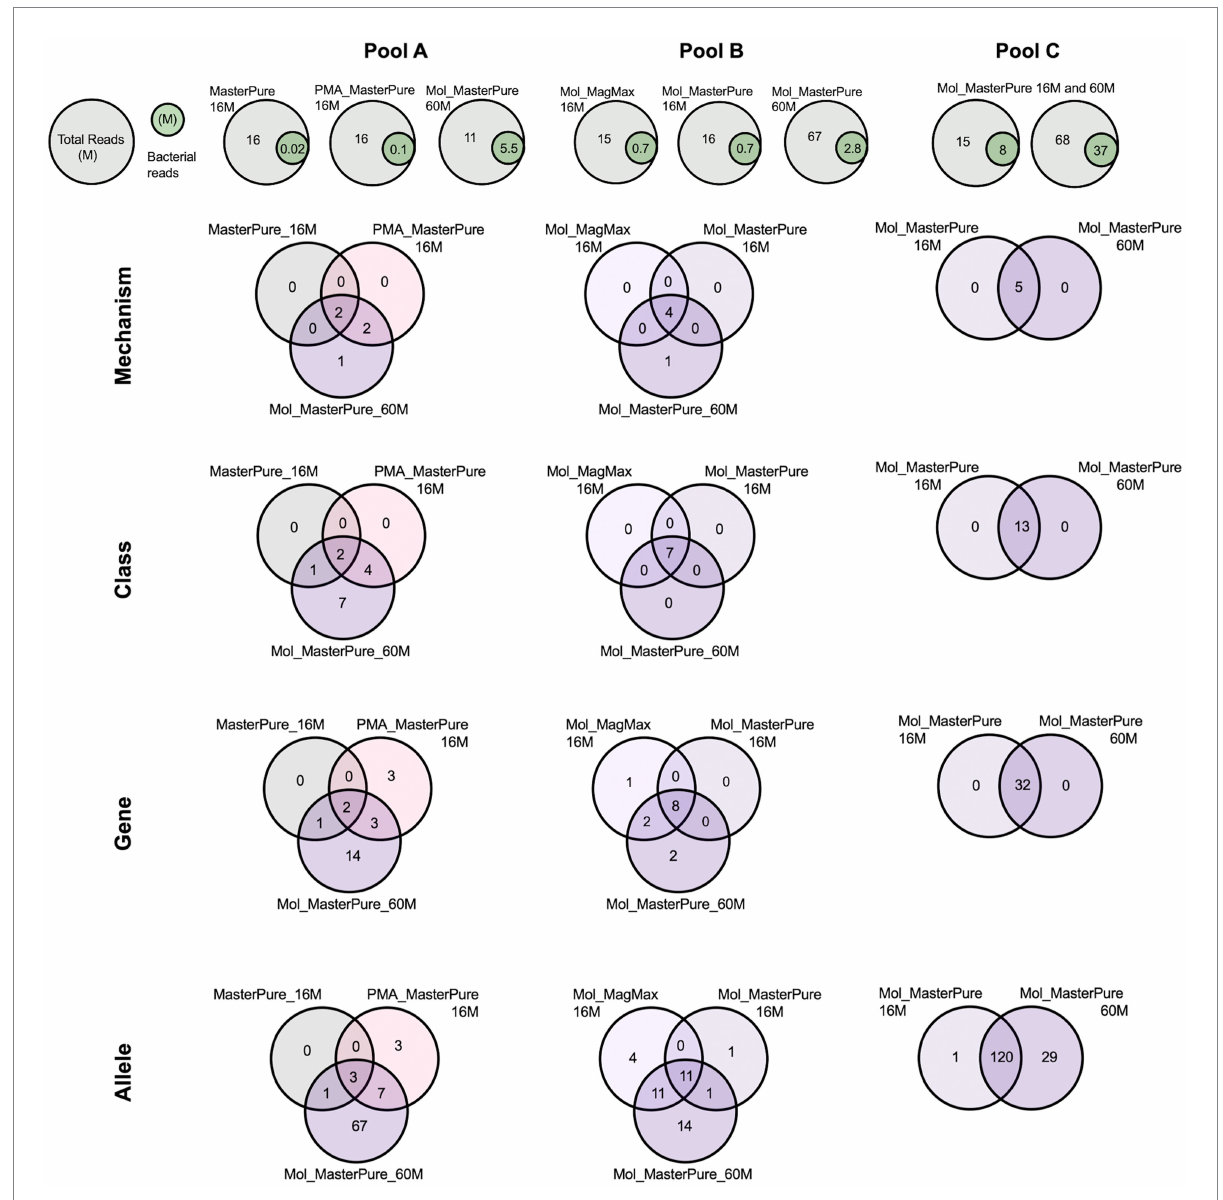
FIGURE 6 Venn diagrams representing intersection of different resistome annotation levels (Mechanism, Class, Gene, Allele) for patient samples from pools A, B, and C, processed according to different protocols and sequenced at different sequencing depths.